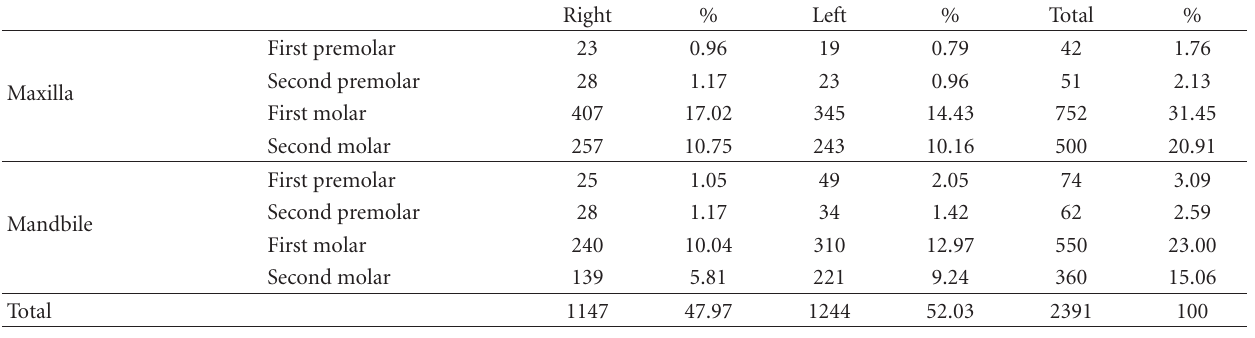
Table 3: The distribution of pulp stone according to dental arches and location.